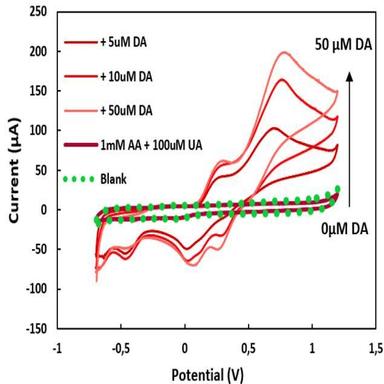
CVs of Nafion/MWCNTs/Pt NPs/TiN electrode in PBS solution (50 mM, pH = 7.4) containing various dopamine concentration in at presence of 1 mM ascorbic acid and100μM uric acid at scan rate of 50 mV/s.